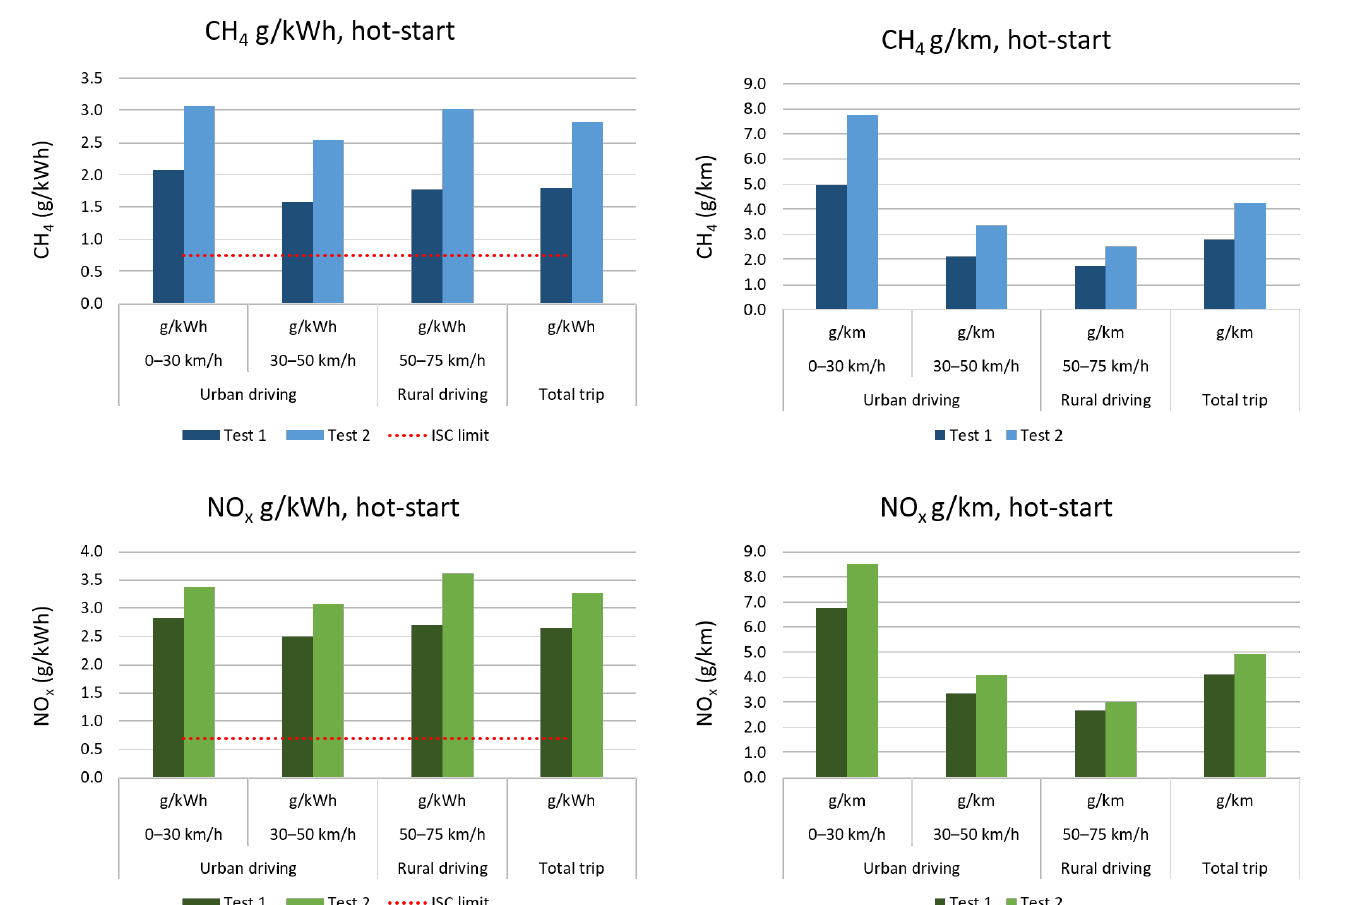
Figure 4. Specific CH 4 and NO x emissions in g/kWh and g/km in hot-start tests.